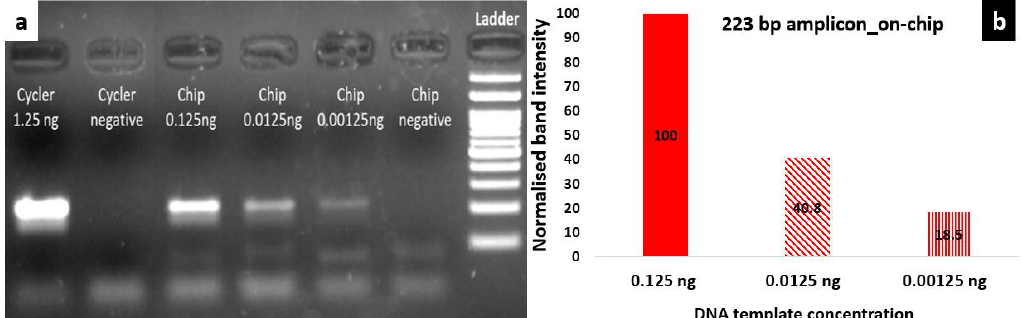
Figure 7. ( a ) Agarose gel electrophoresis image depicting the products (223 bp) from the i-cycler and a static microPCR for purified genomic Salmonella DNA using different template concentrations ranging from 0.125 ng to 0.00125 ng per 25 μL PCR reaction (for on-chip amplification). The on-chip experiments were performed simultaneously, in 4 microfluidic chambers of the fluidic chip, in thermal contact with a thick PCB microheater chip; ( b ) comparison of band intensities (normalized to the intensity of PCR with 0.125 ng DNA template) for the on-chip amplification after 40 cycles of 2T PCR employing 3 different DNA template concentrations.